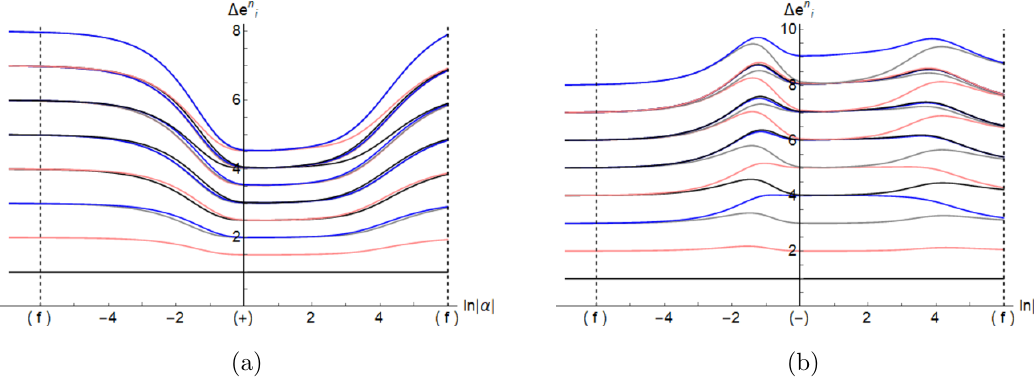
Figure 12. (a) (cid:1) e n versus ln j (cid:11) j for (cid:11) > 0, (cid:1) max = 34 for the (cid:12)xed spectator; (b) (cid:1) e n i for (cid:11) < 0, (cid:1) max = 34 for the (cid:12)xed